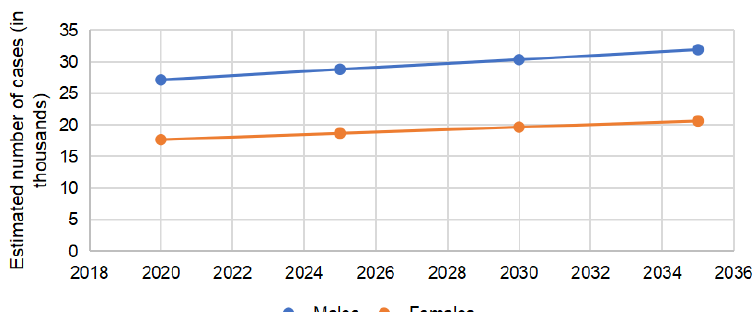
Figure 2. Predicted incidence trends of colon carcinomas in males and females